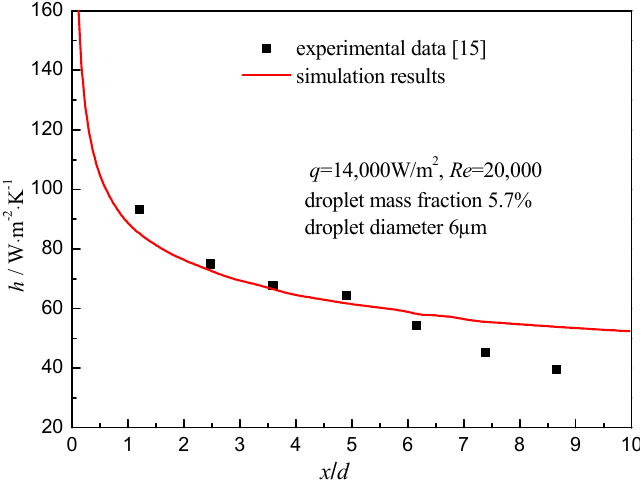
Figure 5. Distribution of the heat transfer coefficient of the horizontal smooth tube mist/steam cooling wall.